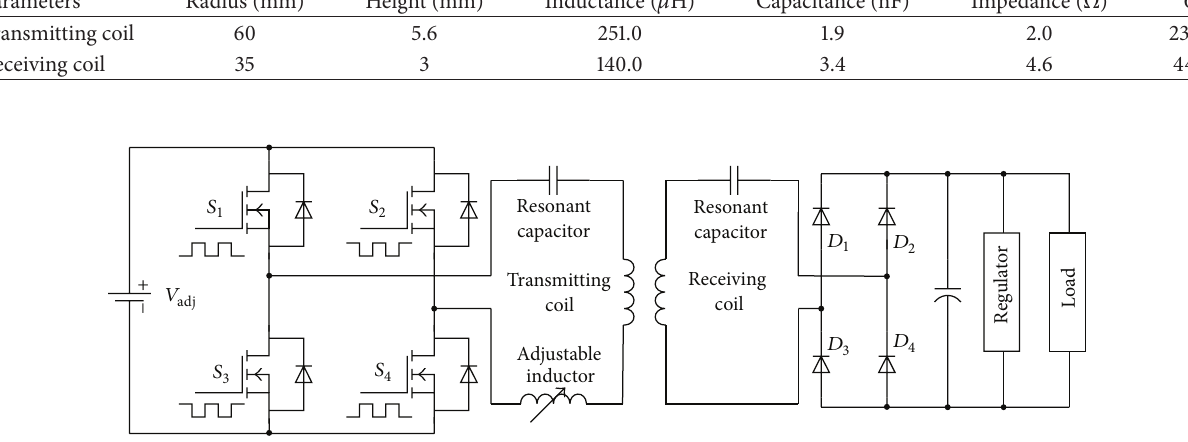
Figure 4: Schematic of the transcutaneous power supply system.